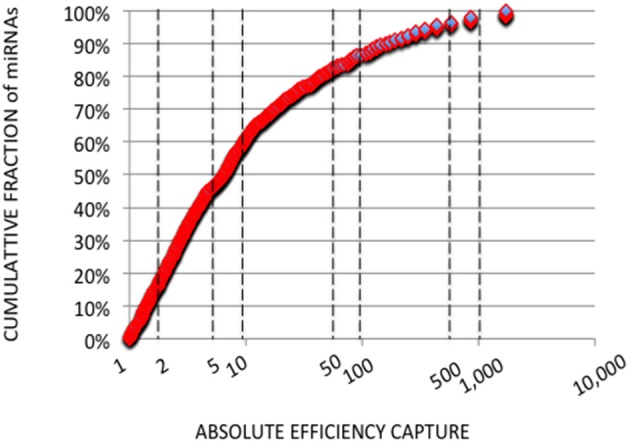
Cumulative Analysis of miRNA Capture Efficiencies. Cumulative fractions of miRNA (Y-axis) were plotted against absolute ECs (X-axis) calculated from the expression profile with a miRNA:3′ adaptor ratio of 1:6 and 16 amplification cycles. Absolute ECs were defined as maximal values between ECs and 1/ECs so that over- and under-expressions are collapsed (ECs of 50 and 0.02 for example). The X-axis is drawn using a log10 scale. About 60 and 85% of the miRNAs displayed absolute ECs lower than 10 or 100, respectively. About 40 and 15% of the miRNAs displayed absolute ECs higher than 10 or 100, respectively, and would artifactually appear as over- or under-abundant.